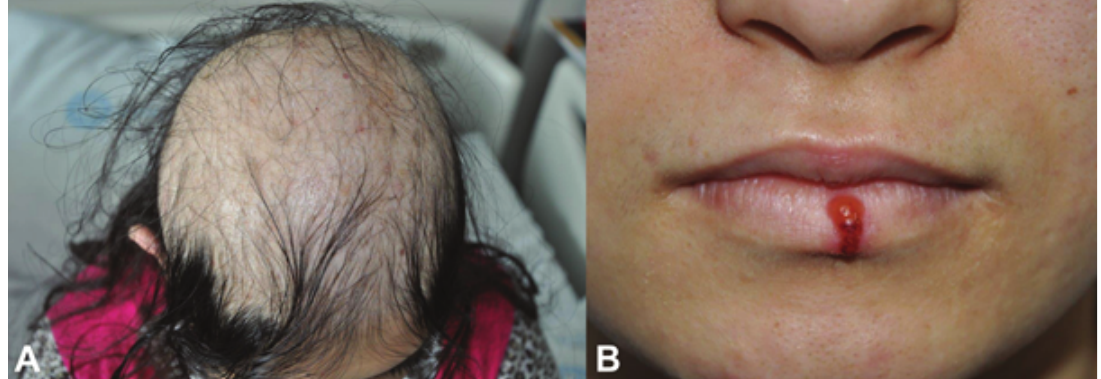
Figure 2. (A) Appearance of hair scalp from above depicting the diffuse alopecia. (B) Colored picture of coexistent Herpes